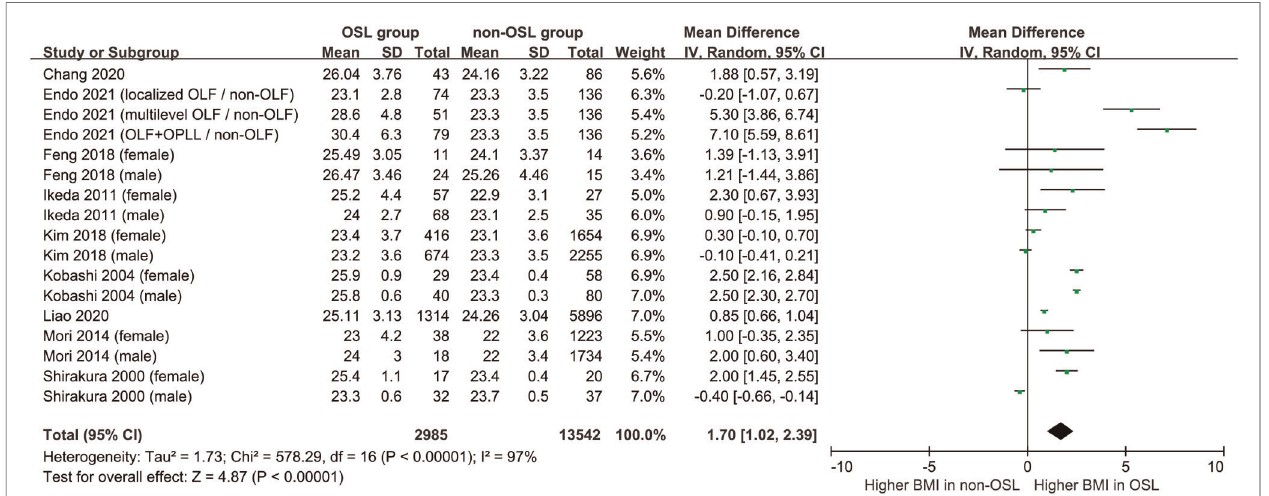
FIGURE 2 | Meta-analysis of the relationship of BMI with the onset of OSL.